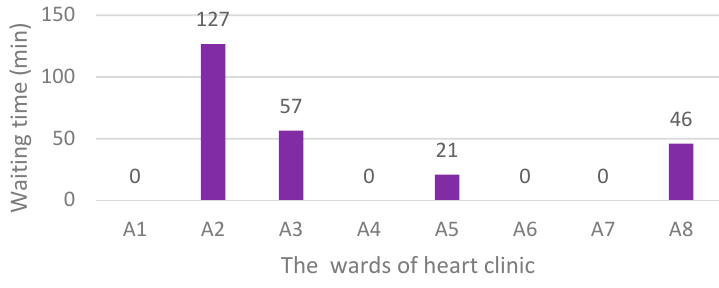
Figure 10. Waiting times after the third scenario implementation.